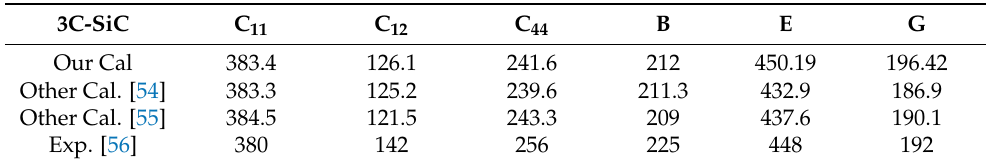
Table 4. The elastic constants (GPa), Bulk modulus B (GPa), Young’s modulus E (GPa) and shear modulus G